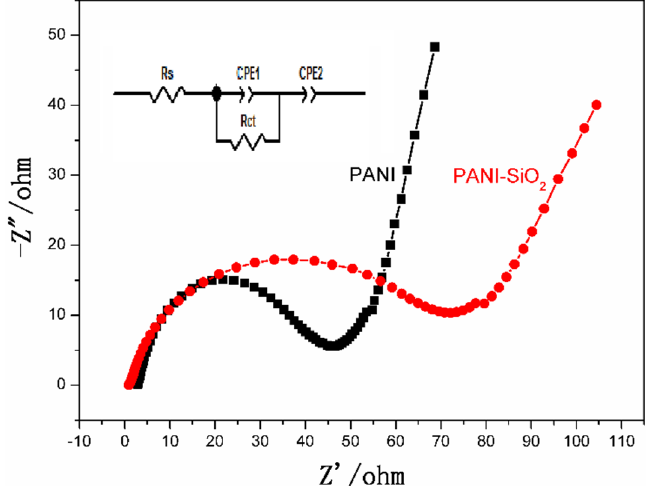
Figure 7. Nyquist plots and equivalent circuit of bulk PANI and PANI-SiO 2 . Rs, serial resistance; CPE, constant phase